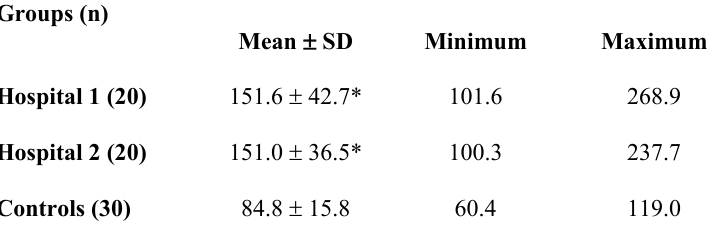
Table 1. Urinary neopterin concentrations in controls and workers in the two hospitals * p < 0.05; versus controls.